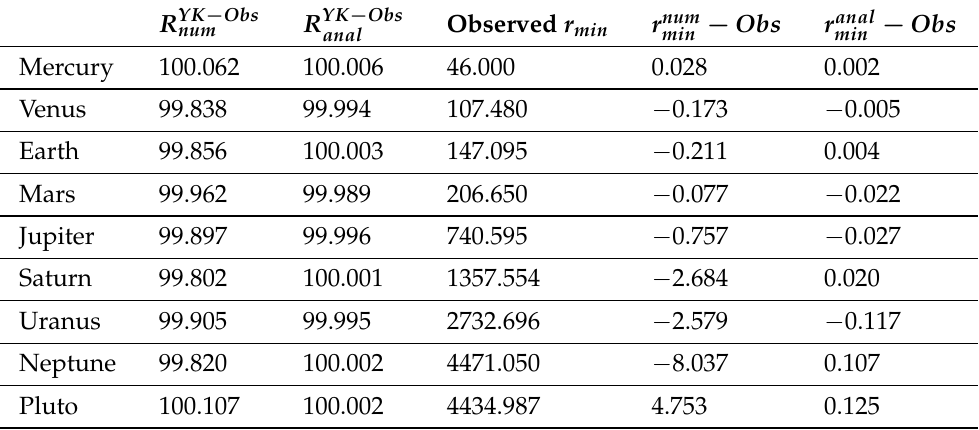
Table A22. Absolute deviation of r min from observation with estimated α , evaluated in (10 6